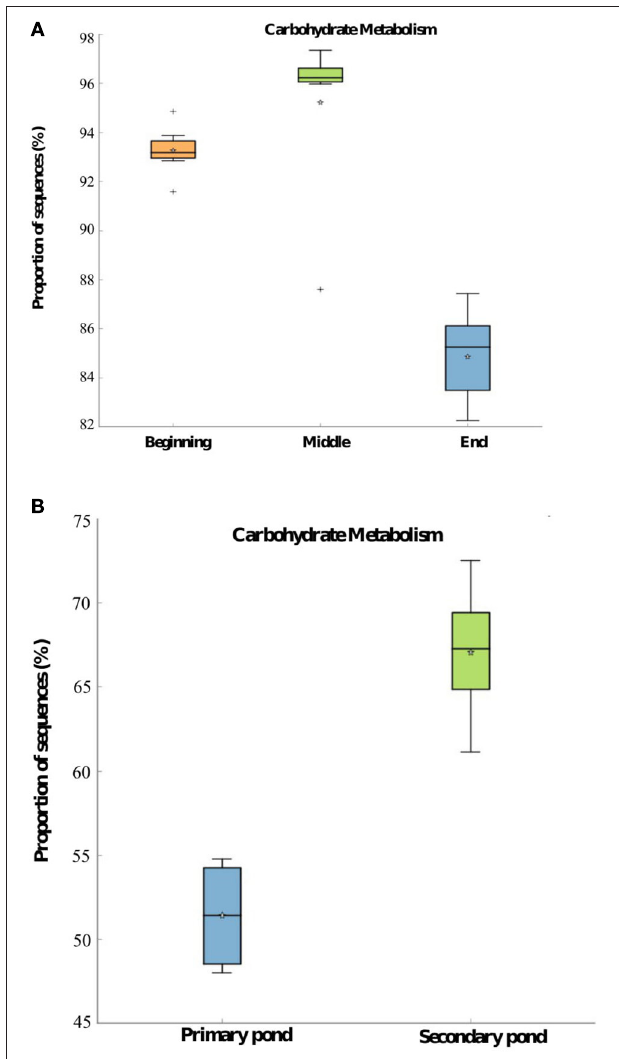
FIGURE 7 | PICRUSt predicted abundance of genes belonging to carbohydrate metabolism with significant differences ( p < 0.05) based on the mean proportions and identities of 16S rRNA genes in pond samples obtained (A) from the beginning to the end of the 2014 treatment season in Pond Inlet, and (B) from the primary and secondary pond in Clyde River at the end of the 2014 treatment season. Significant differences ( p < 0.05) were detected by the Kruskal-Wallis H-test with a multiple test correction Benjamini-Hochberg FDR for the Pond Inlet analysis and the Welch’s t -test with a multiple test correction Benjamini-Hochberg FDR for the Clyde River analysis. *: mean. + :